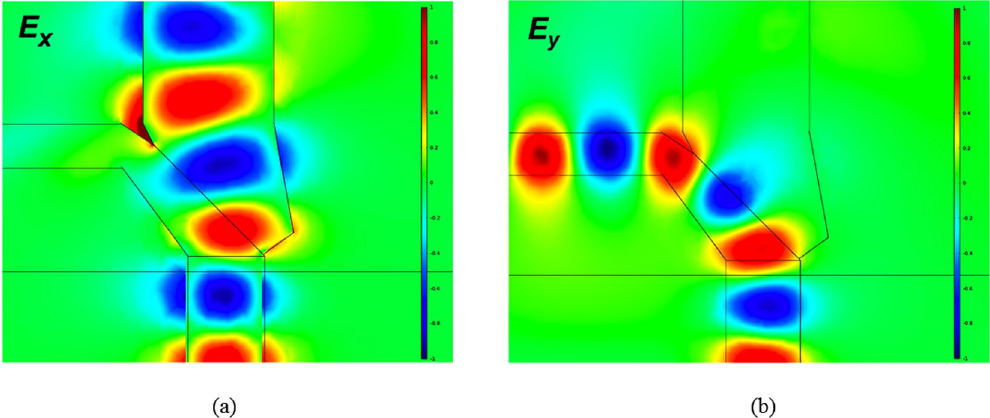
Figure 5. The propagating electric field distributions of the ( a ) TE (electric field component, E x ) and ( b ) TM (electric field component, E y ) modes.